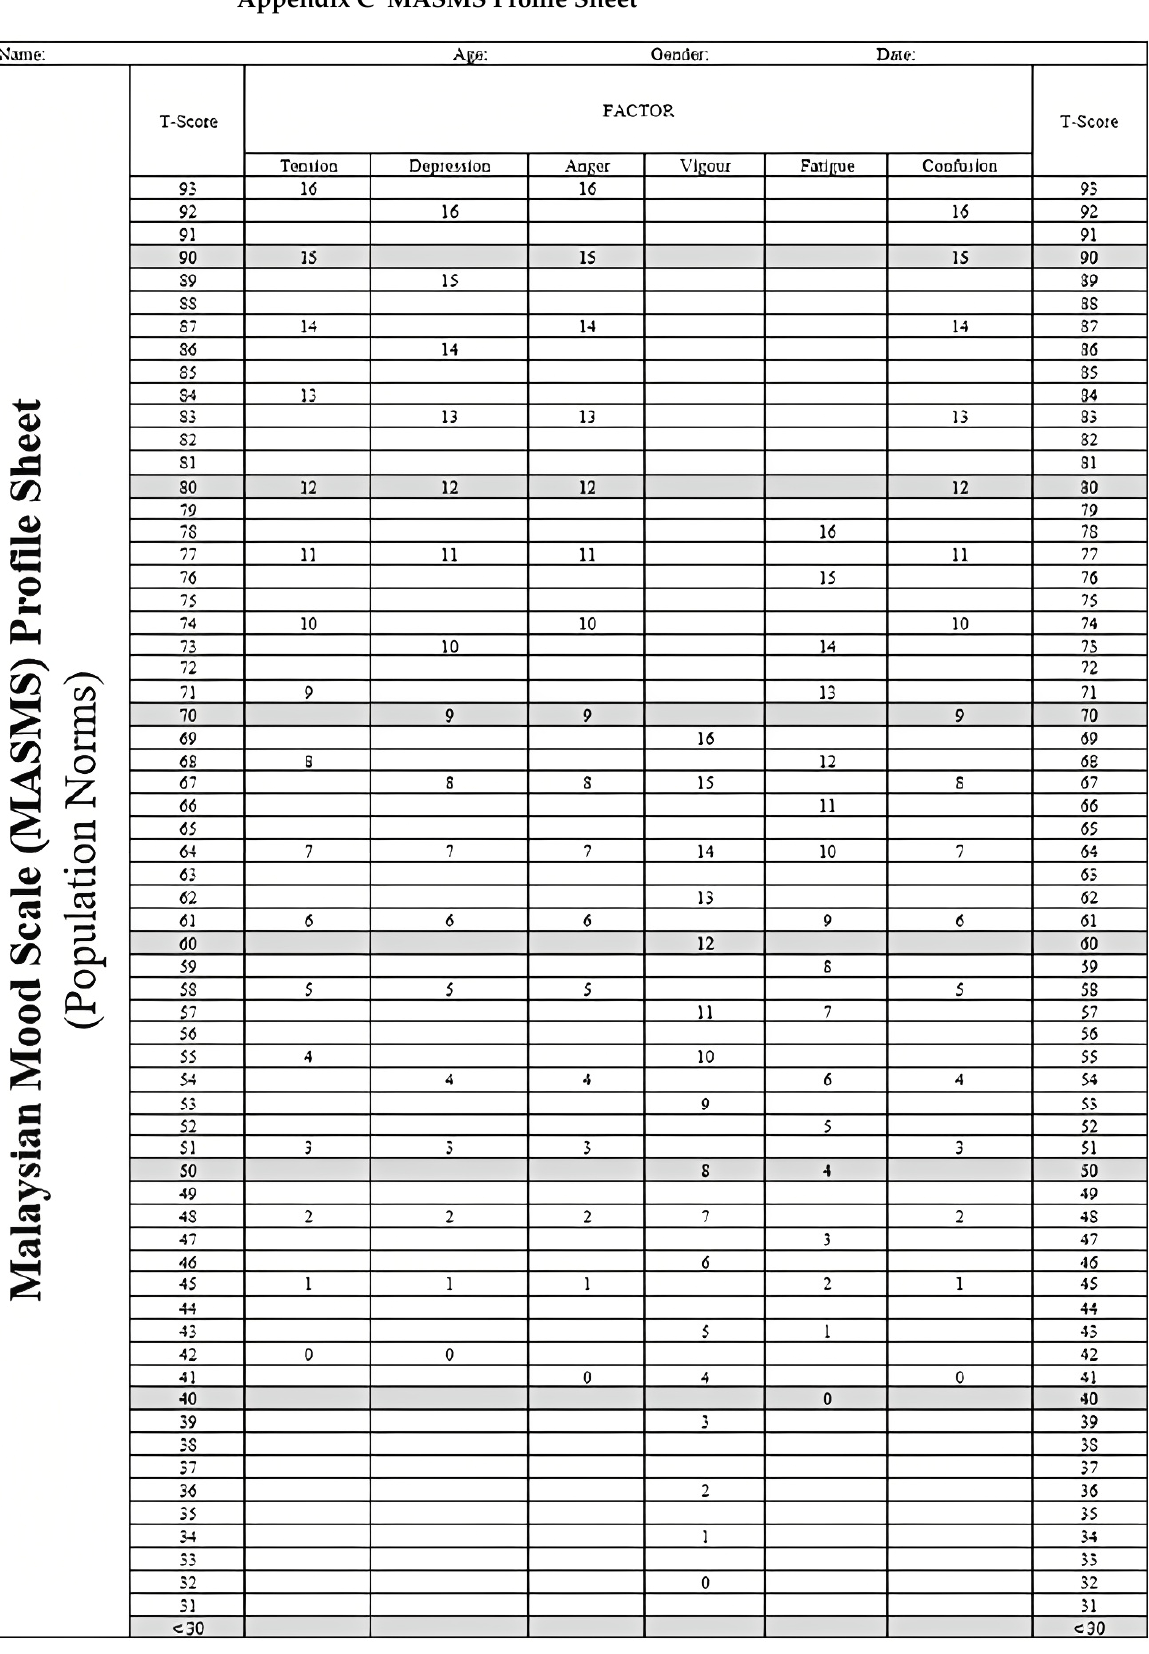
Figure A1. MASMS profile sheet (population norms).